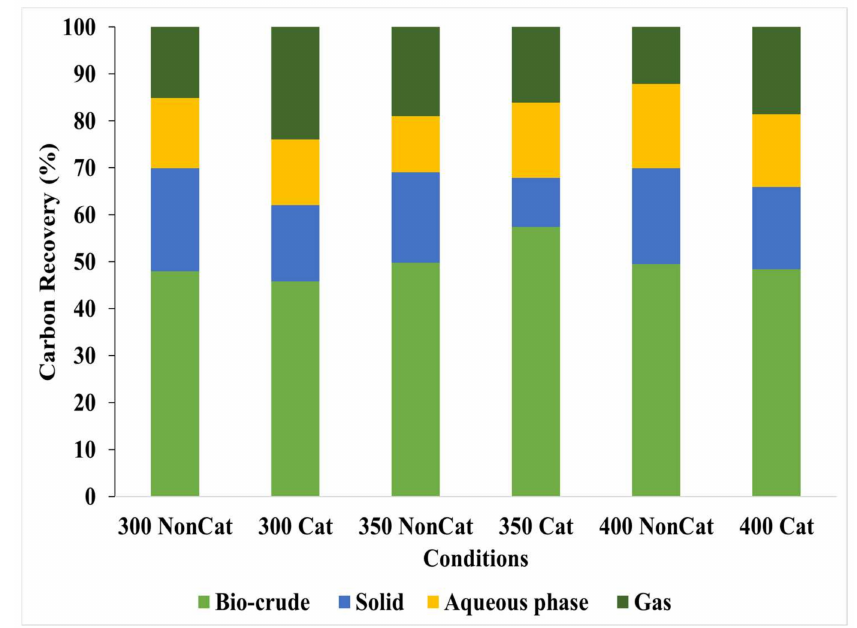
Figure 7. Carbon recovery in HTL